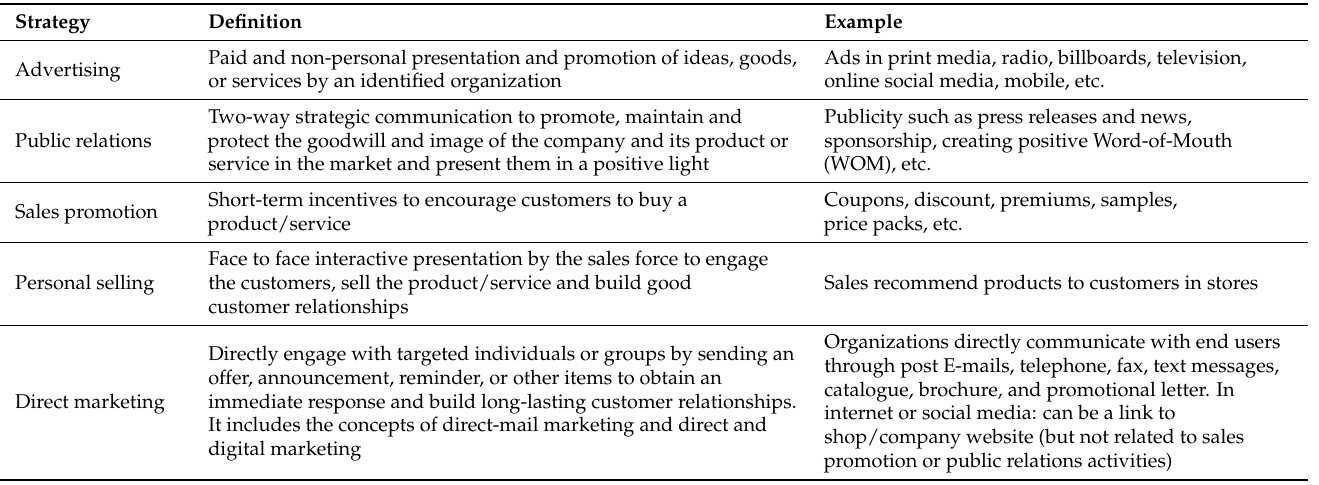
Table A1. Marketing communication strategy definitions and examples.